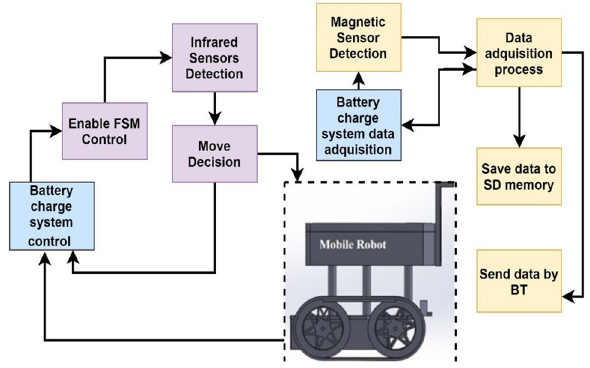
Fig. 12 Complete system for mobile robot control